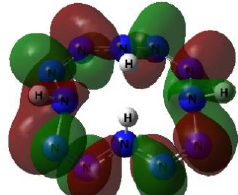
LUMO (alpha, beta) ( − 2.699)